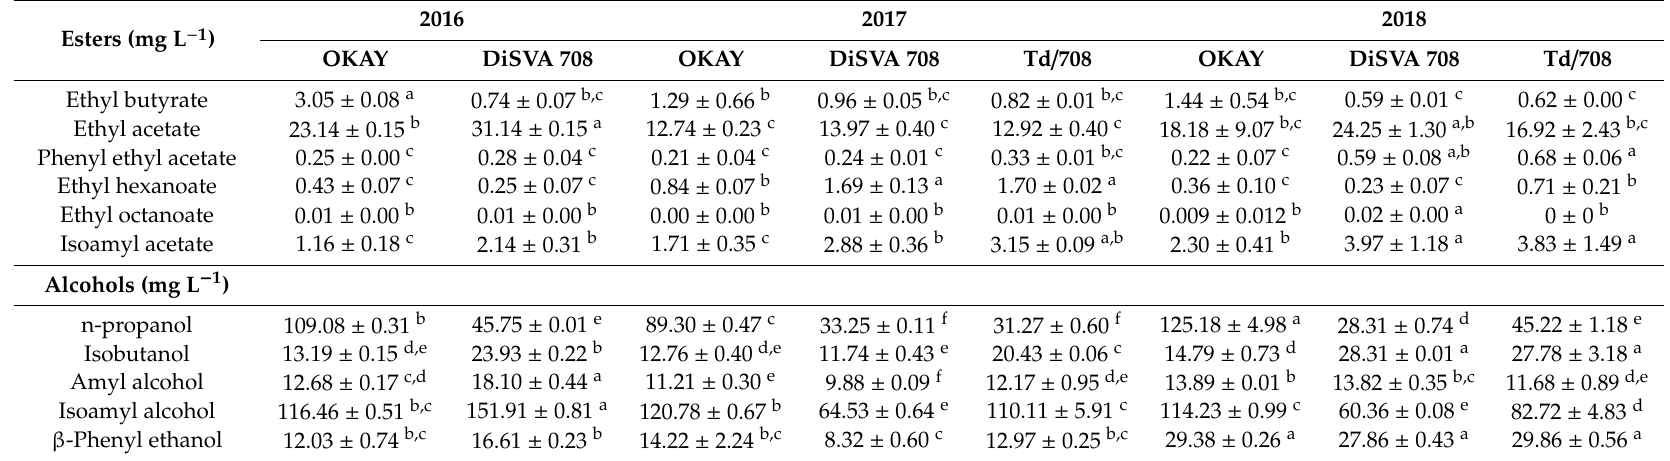
Table 3. The main by-products of fermentation and volatile compounds of the wines obtained for vintages 2016–2018, in pure and in sequential fermentations with the non -Saccharomyces strain added 2 days prior to the S. cerevisiae DiSVA 708 strain. Data are means ± standard deviations. Values displaying di ff erent superscript letters ( a,b,c,d,e,f ) within each line are significantly di ff erent according to Duncan tests ( p < 0.05). The abbreviation Td / 708 indicates the sequential fermentations carried out by T. delbrueckii / S. cerevisiae DiSVA